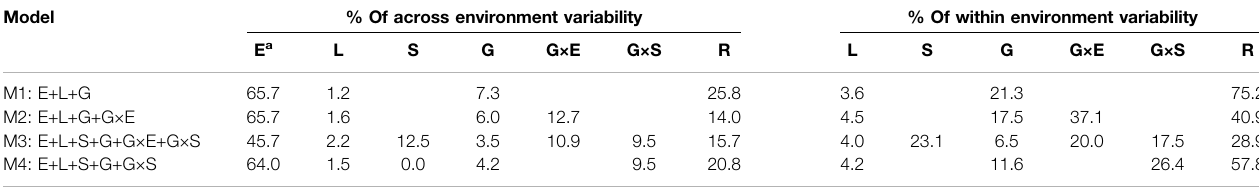
TABLE 1 | Percentage of phenotypic variability explained by the different model components across and within environments for the four models (M1 – M4). Model